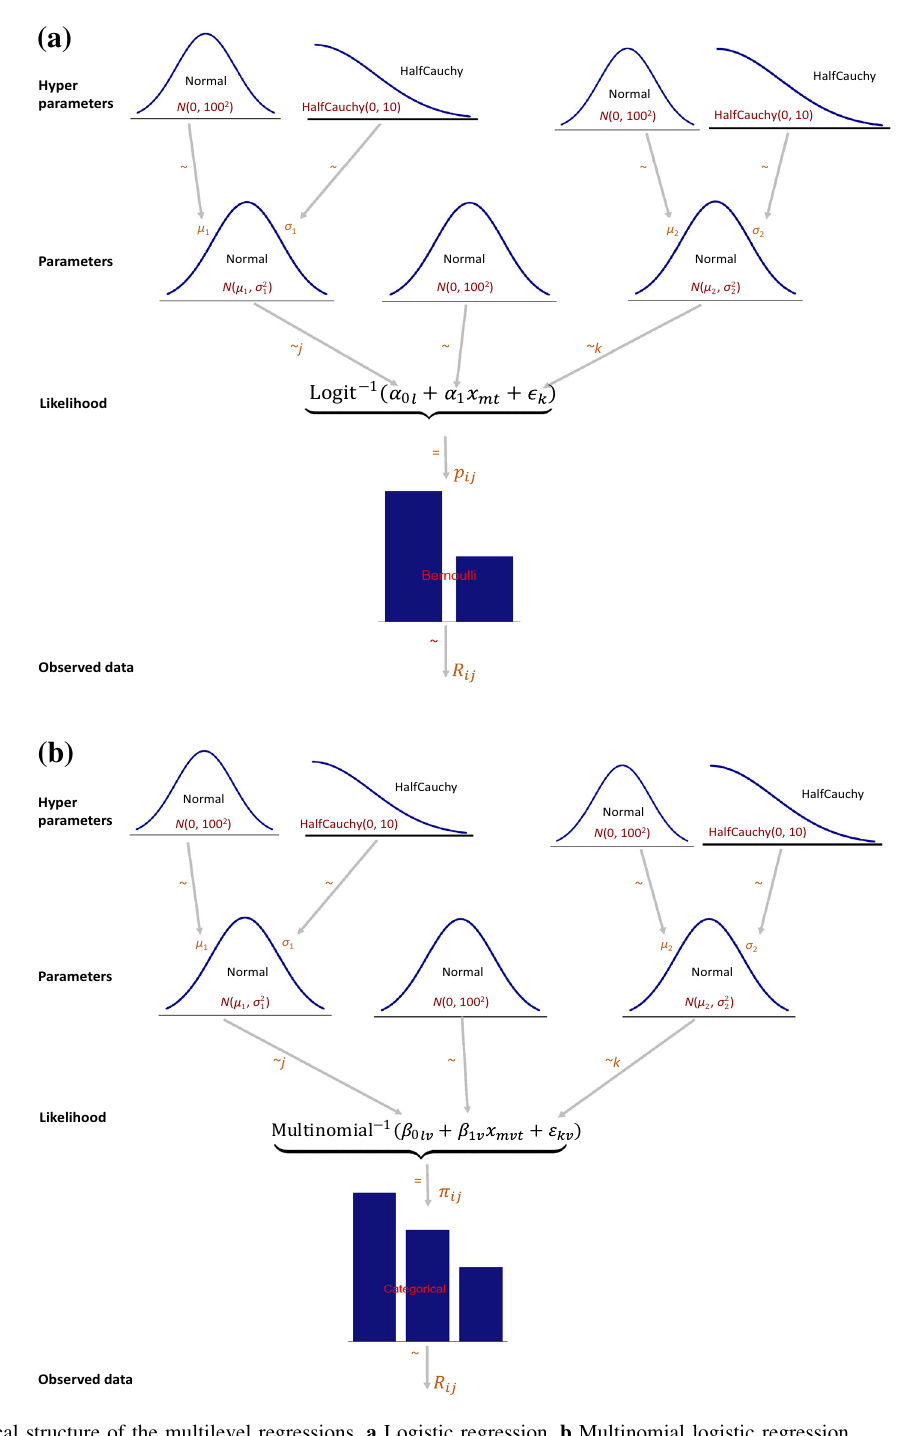
Fig. 3 Hierarchical structure of the multilevel regressions. a Logistic regression. b Multinomial logistic